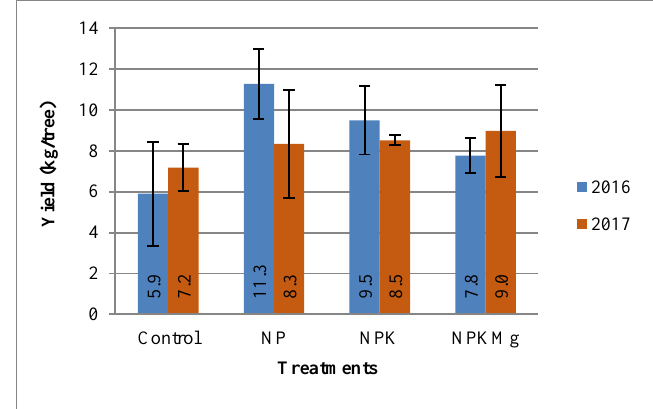
Figure 1 . Harvested fruit amount sweet cherry cultivar ‘Carmen’ (Debrecen-Pallag, 2016-2017). In 2016, crop load (fruit amount calculated to the trunk thickness) was higher with all treatments ( Figure 2 ) . Fertilized trees displayed 152-180 g/cm 2 values, as control treatment presented only 94 g/cm 2 . In 2017, crop load was lower, due to the unfavorable weather events in spring. The highest values were measured in NPKMg treatment (115 g/cm 2 ), followed by NPK treatment (93 g/cm 2